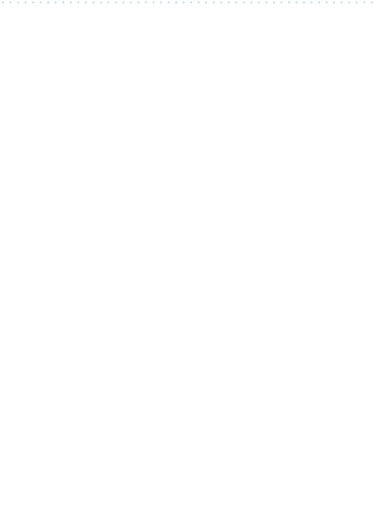
Figure 1. Preparation process (left: a – d ), the prepared 2-inch sample (right: e – h ).